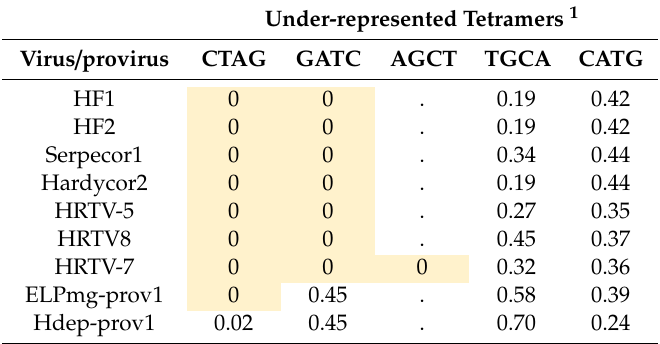
Table 3. Under-represented palindromic tetramers in HF1-group virus genomes. Under-represented Tetramers 1 Virus / provirus CTAG GATC AGCT